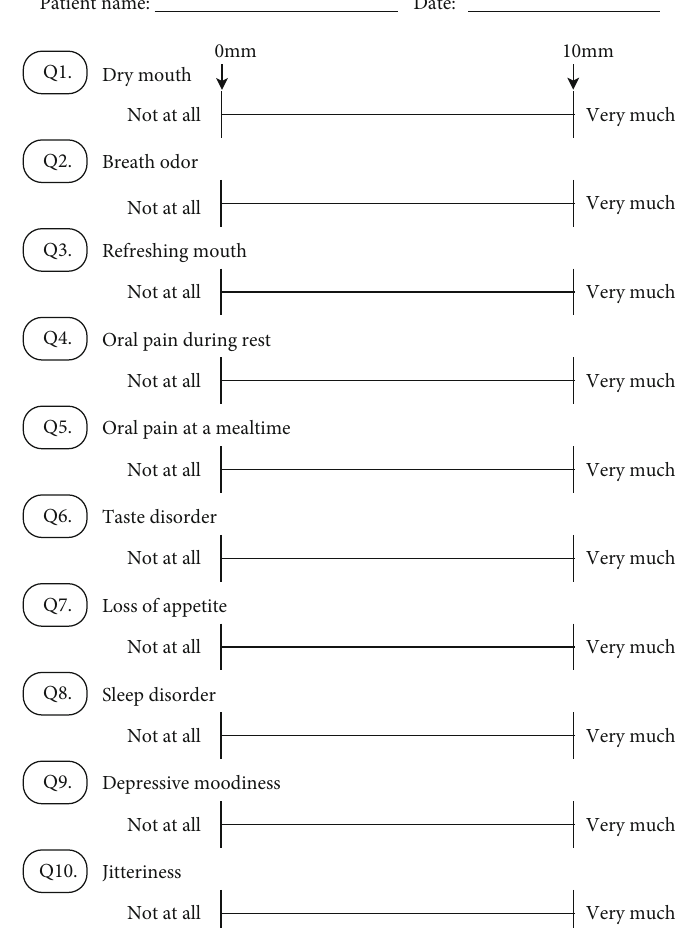
Figure 1: The VAS of 10 items. The VAS is a horizontal line, 100mm in length, anchored by word descriptors at each